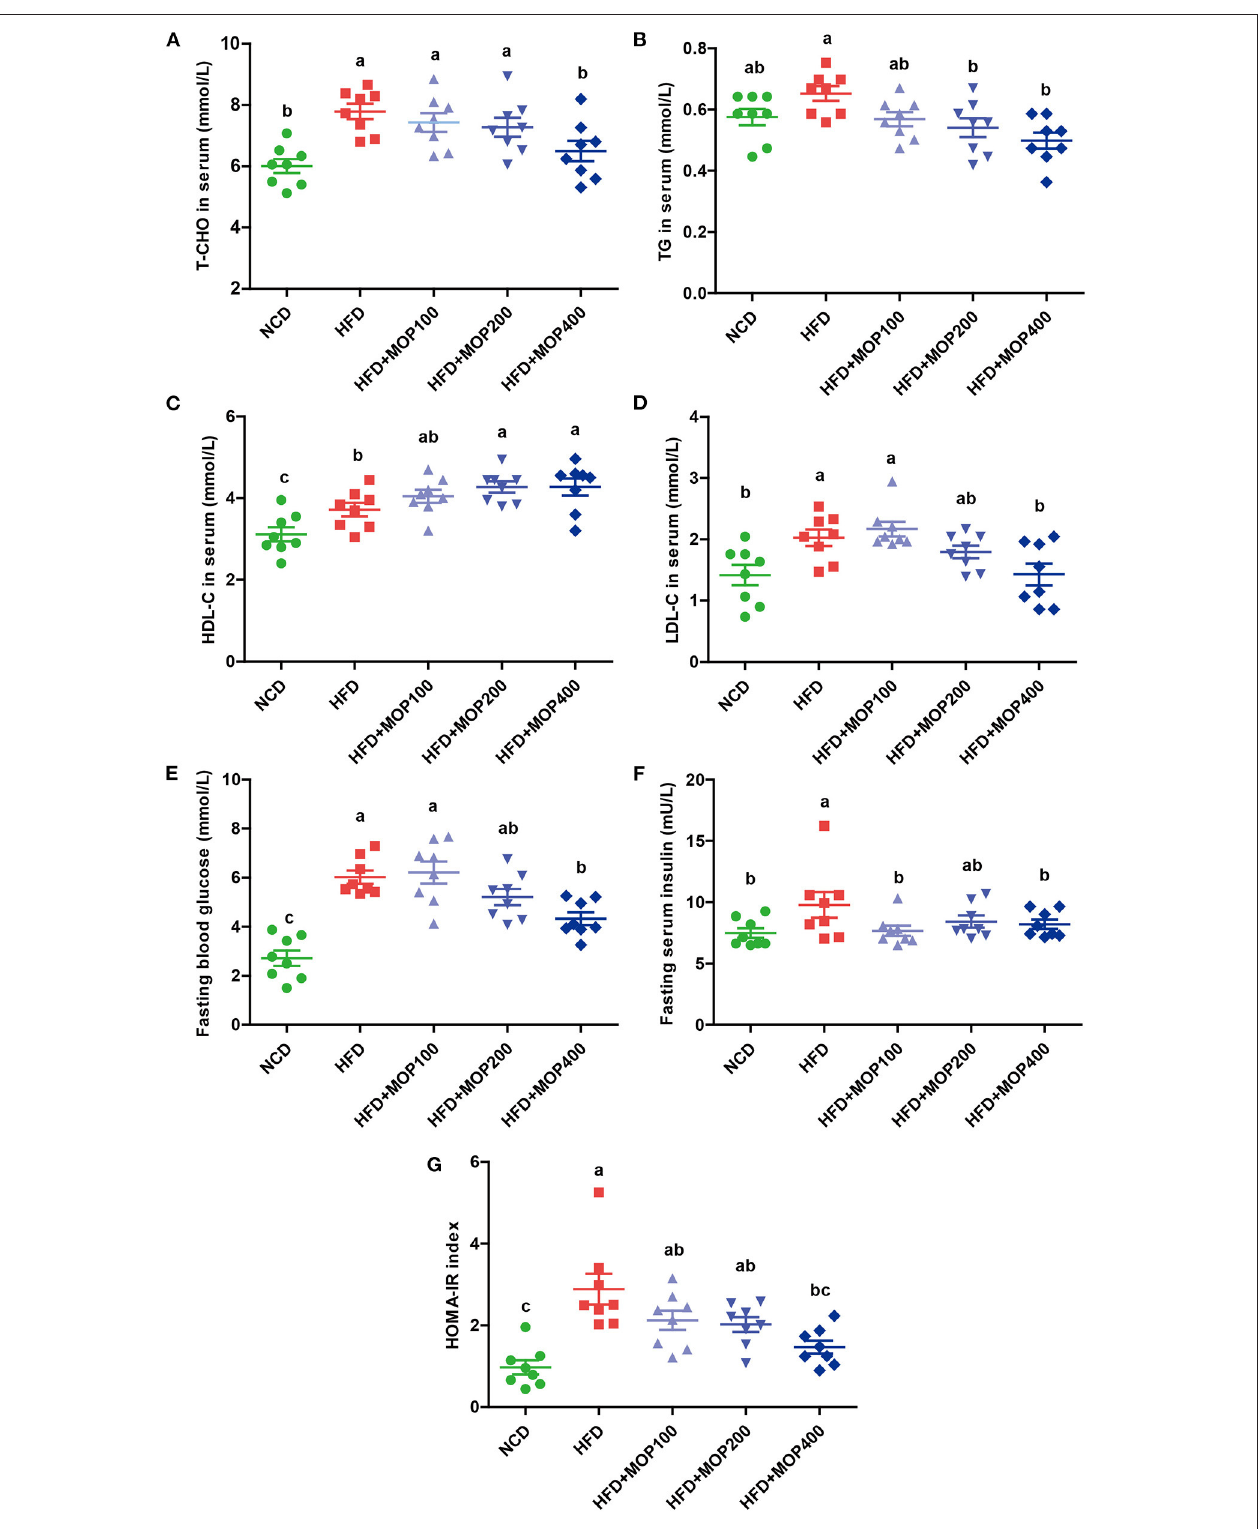
FIGURE 3 | MOP ameliorates blood lipid levels and insulin resistance in HFD-fed mice ( n = 8 mice/group). Serum levels of (A) total cholesterol (T-CHO), (B) triglycerides (TG), (C) high-density lipoprotein cholesterol (HDL-C), (D) low-density lipoprotein cholesterol (LDL-C), (E) Fasting blood glucose, (F) fasting serum insulin, (G) homeostasis model assessment of insulin resistance (HOMA-IR) index. Data are shown as means ± SEM. Bars marked with different superscript letters (a-c) indicate significant differences at p < 0.05 based on one-way ANOVA with Duncan’s post-hoc test.